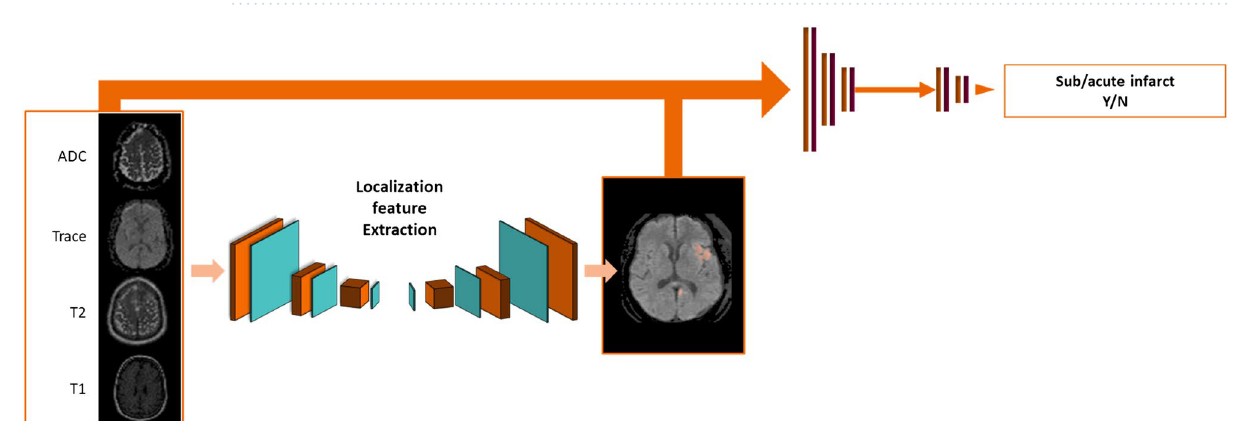
Figure 3. Critical network architecture. The same architecture is used for acute hemorrhage, mass effect and acute infarct, but is trained using different inputs. The network for infarct is shown above; the corresponding network for mass effect used axial FLAIR, T1W and T2W contrasts, and the network for hemorrhage used all axial contrasts. Note that for all three critical findings, the input contrast selection (see ‘training’ section) resulted in sagittal images not being used, simplifying the architecture compared to Fig.